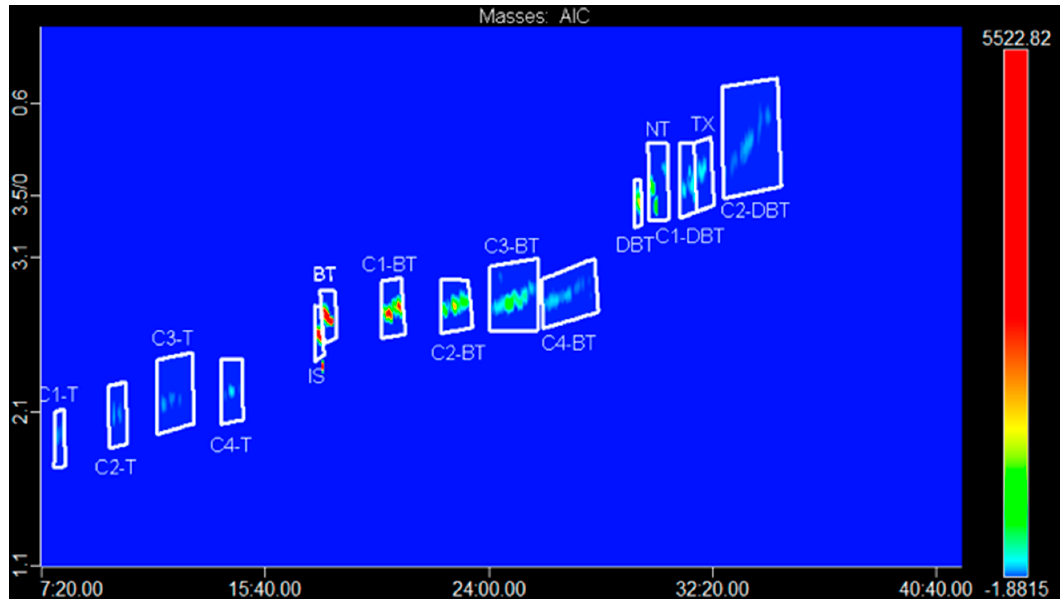
Figure 2. Analytical ion chromatogram showing the OSCs found by the targeted process. Abbreviation: TX = Thioxanthene.